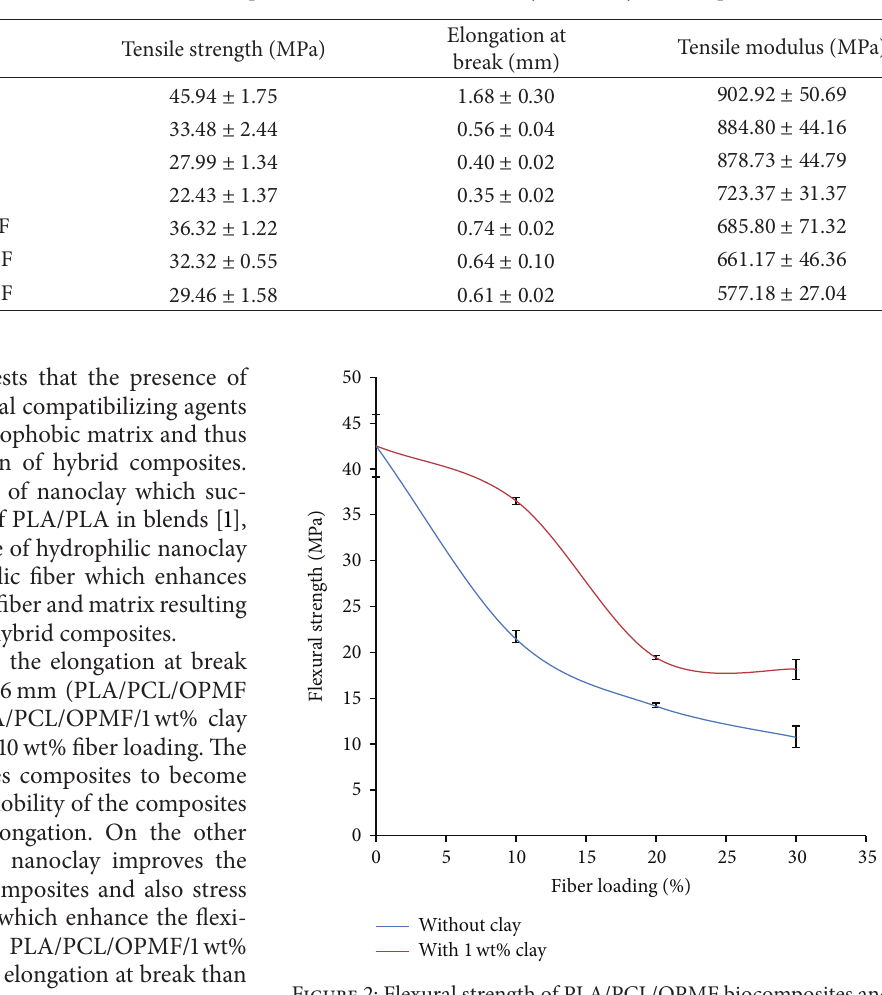
Table 1: Tensile properties of PLA/PCL/OPMF biocomposites and PLA/PCL/1 wt% clay/OPMF hybrid composites.